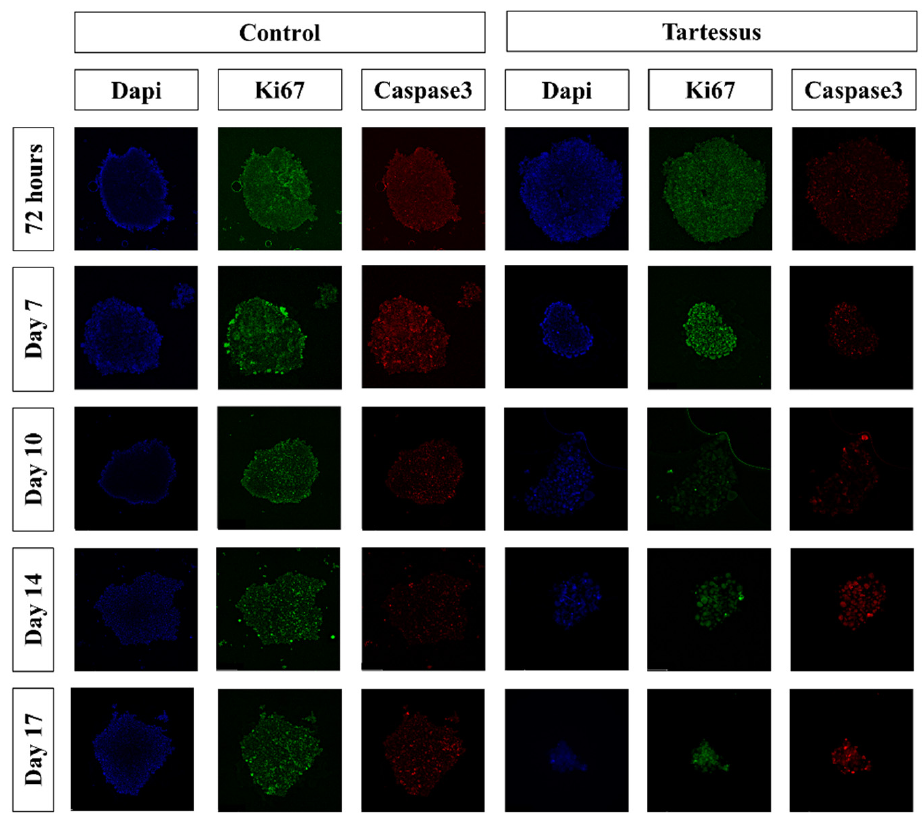
Figure 6. Immunofluorescence staining of the 3D cultures. Blue: cell nucleus (DAPI); red: anti-caspase 3 antibody; green: anti-Ki67 antibody.